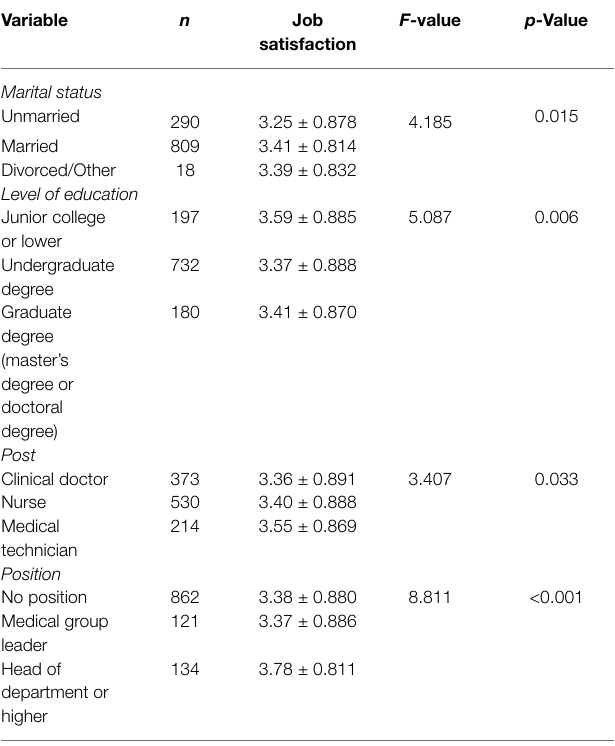
TABLE 4 | One-way ANOVA of job satisfaction of health workers with different demographic characteristics. Variable n Job F -value p- satisfaction